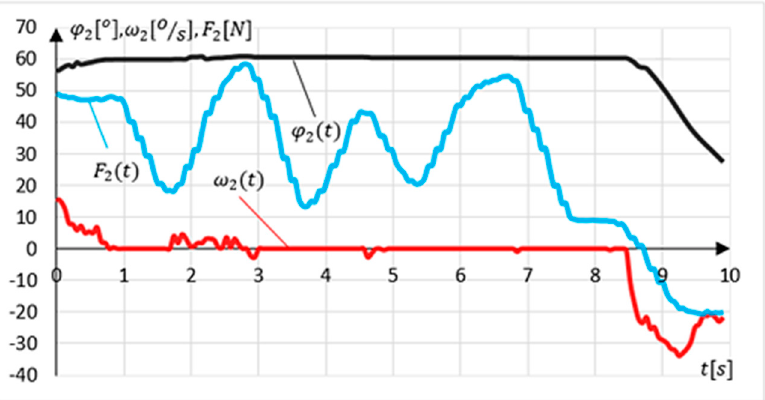
Figure 21. Result of preventing the movement from exceeding the range of motion ( ϕ 2 max = 60°). During this experiment, the measured value ϕ 2 P = 56.9°. Three pulsed attempts to exceed the range of motion were detected at t 1 = 2.88 s, t 2 = 4.62 s, and t 3 = 6.66 s. The greatest force F 2 = 58.0 N was measured during the first attempt. During this test, a slight deviation of the position ( ∆ ϕ 2 = 0.87°) was observed. During the remaining attempts, no change in the angular position of the mechanism was observed.